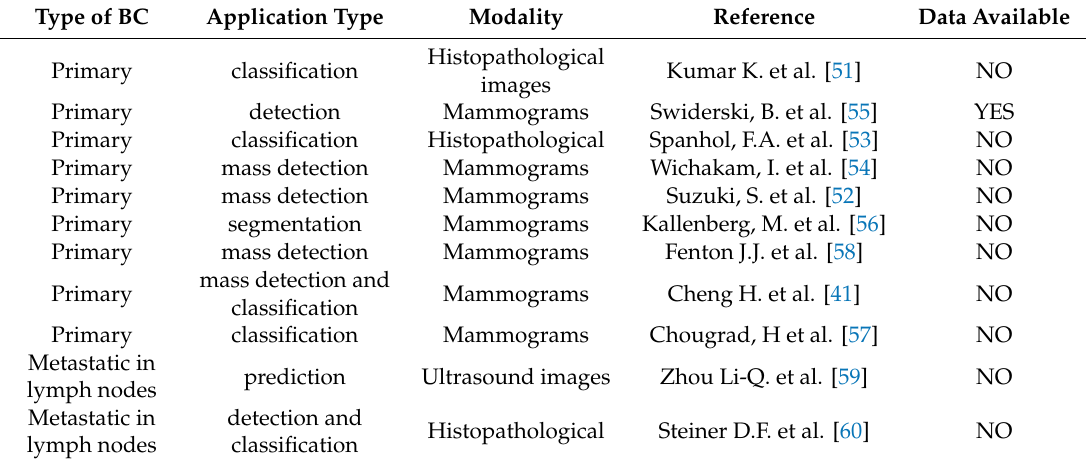
Table 1. Summary of representative convolutional neural networks (CNNs) for breast cancer (BC)